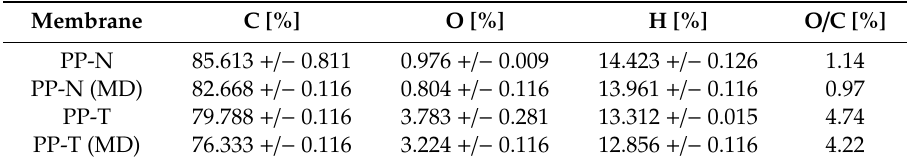
Table 5. The results of elemental analysis.